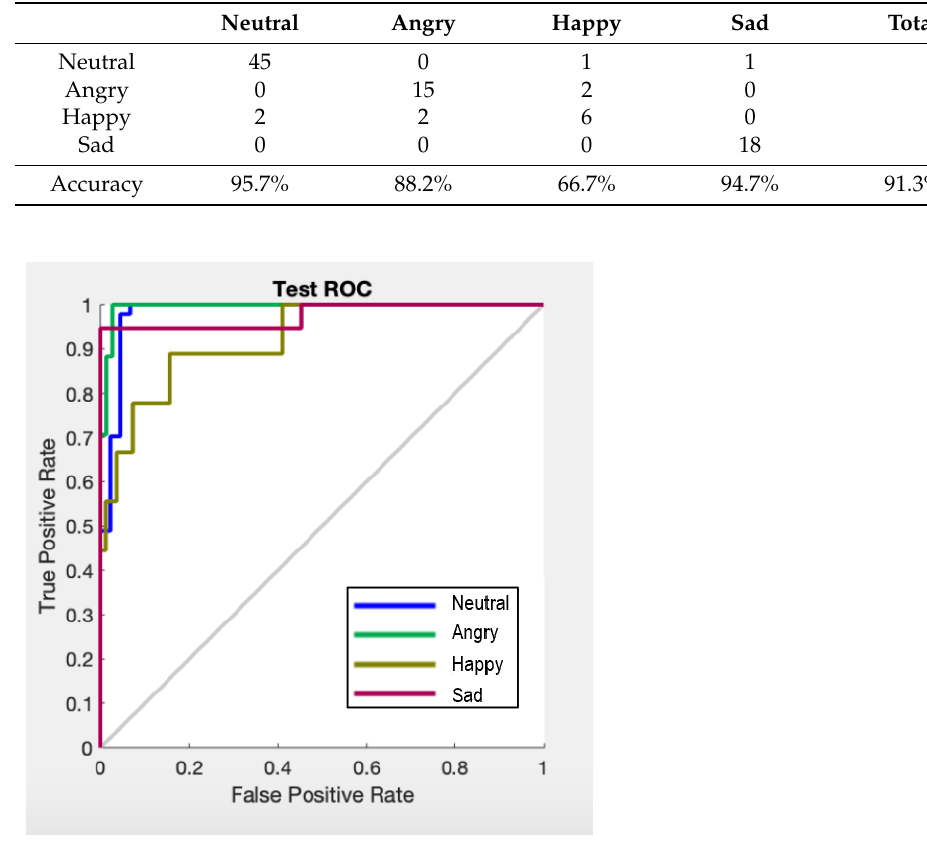
Figure 5. ROC test using the Berlin Database of Emotional Speech. Blue: Neutral. Green: Angry. Dark Yellow: Happy. Purple: Sad. Table 1. SER model emotion categorization results on the testing data set (91.3% accuracy).